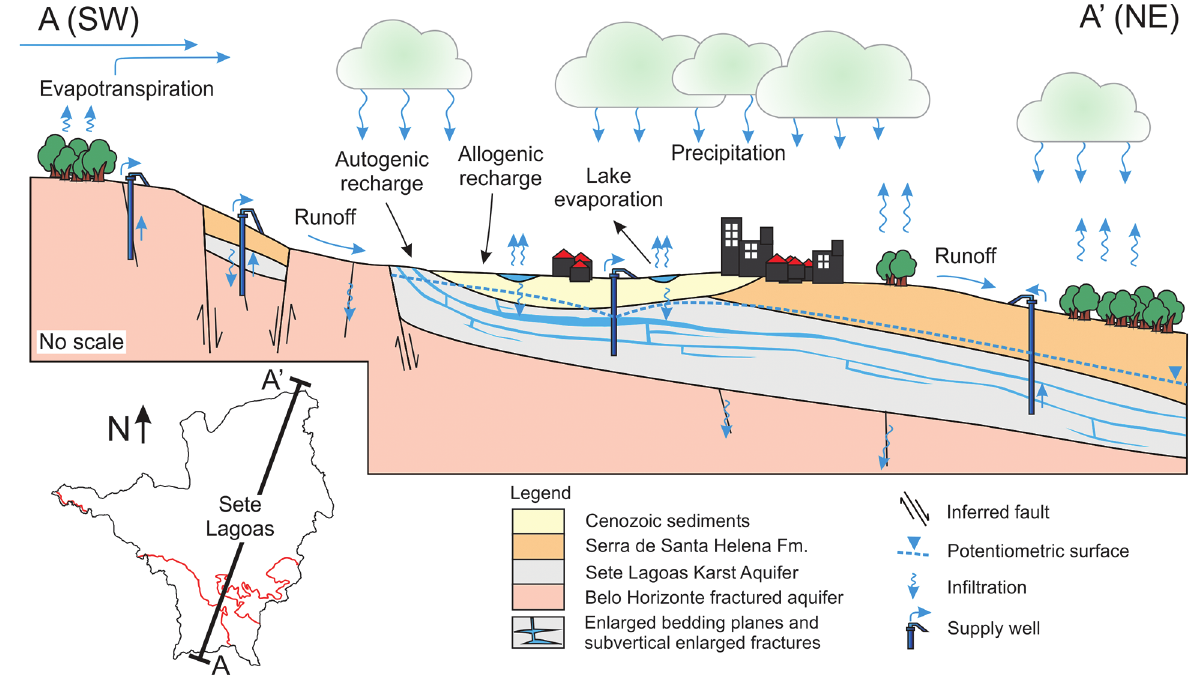
Figure 2 – A schematic hydrogeological section of the city of Sete Lagoas describing the groundwater circulation in the central urban area. The karst aquifer is confined, where the potentiometric surfaces are above the two karstic bedding planes. Locally, the shallowest bedding plane is found dry due to high well supply extractions, causing temporary unconfined conditions (modified from Galvão et al. in